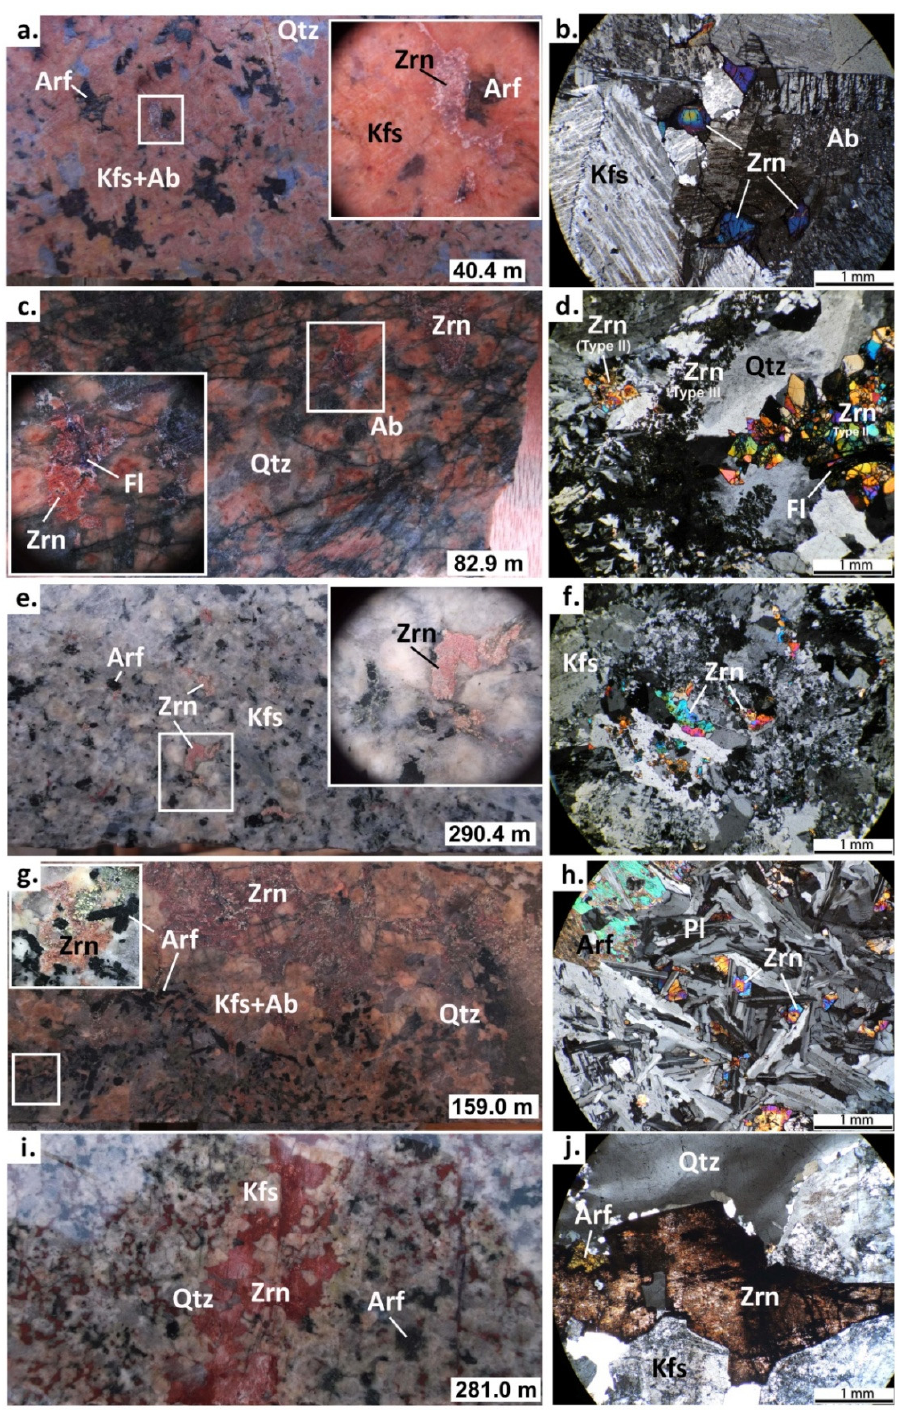
Figure 4. Rock units and photomicrographs. ( a , b ) quartz syenite; ( a ) coarse-grained quartz syenite that contains arfvedsonite, feldspars, and quartz with zircon, ( b ) feldspars with zircon (Type-I). ( c , d ) Metasomatized quartz syenite; ( c ) albitized quartz syenite that contains quartz, zircon and fluorite, ( d ) euhedral and subhedral Type-II zircon and anhedral fine-grained Type-III zircon with quartz and fluorite. ( e , f ) Granite; ( e ) fine-grained granite containing arfvedsonite, feldspar, and quartz with Type-I zircon, ( f ) zircons disseminated in the granite. ( g – j ) Pegmatite; ( g ) pegmatite with fine amphibole, large feldspar, quartz. White-colored zircons disseminated, ( h ) zircons interstitial to albite, ( i ) 1 cm-thickpegmatite that contains brown-colored zircon, quartz, and feldspar, ( j ) Zircon with quartz and feldspar. Abbreviations: Ab, albite; Arf, arfvedsonite; Kfs, K-feldspar; Pl, plagioclase; Qtz, quartz; Zrn, zircon; Fl, fluorite.